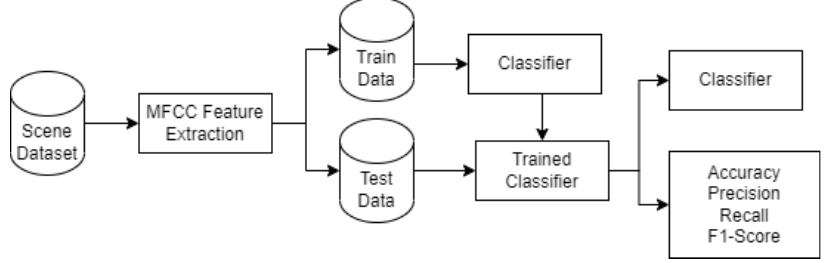
Figure 2. Scene classification model.